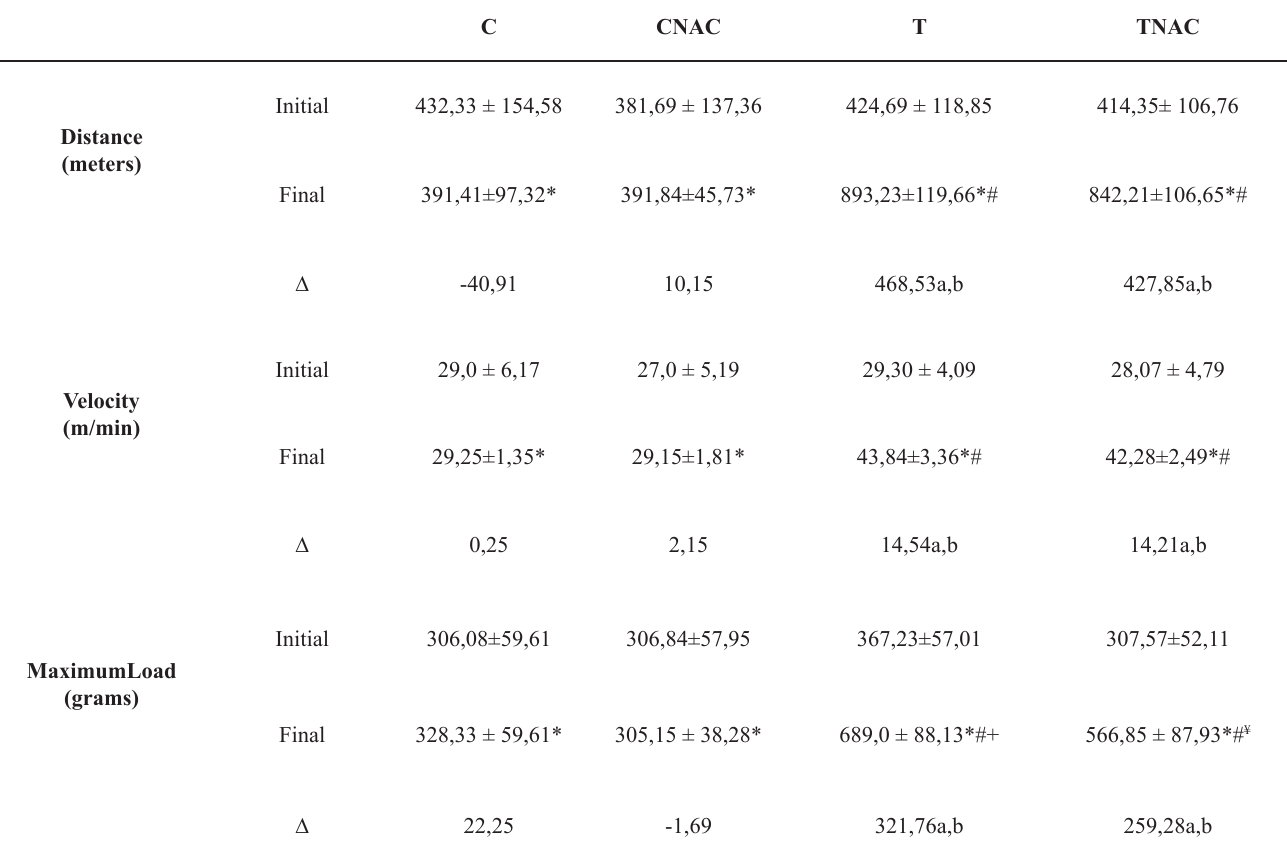
Table 4. Physical aerobic capacity and maximum load for resistance training.